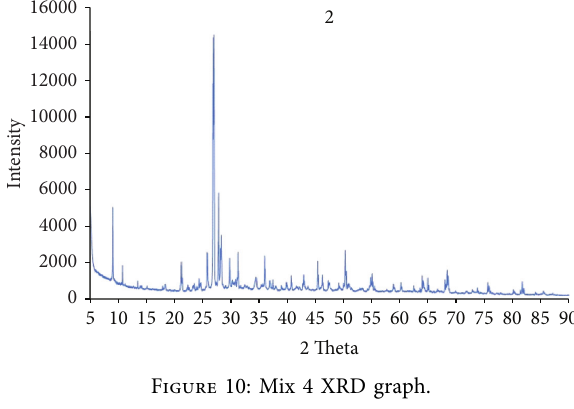
Figure 10: Mix 4 XRD